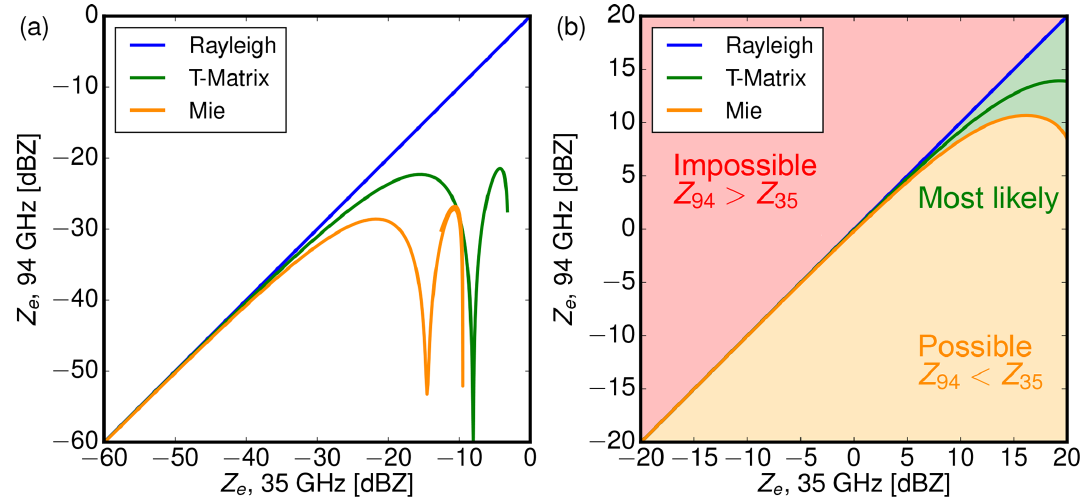
Figure 10. Comparison between modeled effective reflectivities at 94GHz against effective reflectivities at 35GHz according to Rayleigh (blue), Mie (solid) and T-Matrix (dashed) theory. (a) Z e for mono-disperse ice crystals (soft spheroids), (b) Z e for the whole distribution shown in Fig. 8. Overall, the results for both wavelengths are almost identical for small particle sizes and thus small Z e , while Z e at 94GHz is smaller than at 35GHz for larger particles and thus larger Z e